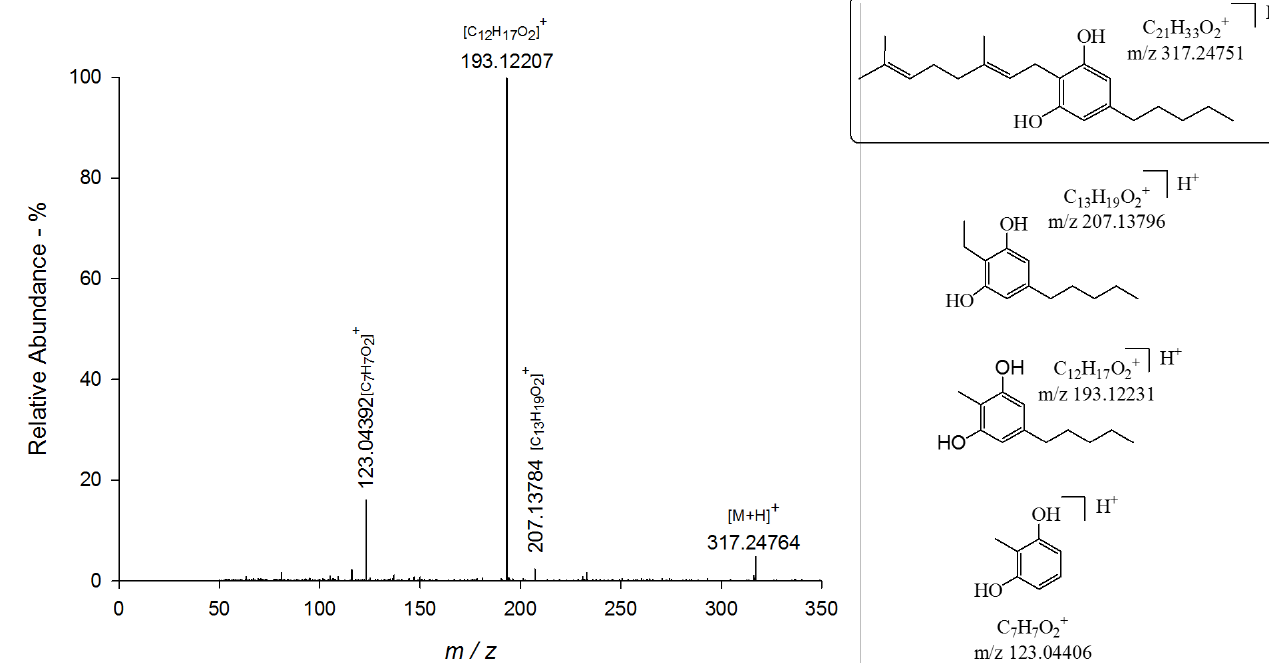
Figure 7. FTICR IRMPD MS spectrum, of the protonated cannabinoid CBG at m / z 317.24764 (peak three in the chromato- grams of Figure 1); the [M+H] + precursor ion was photon-irradiated for 290 ms at 100% laser power to obtain the product ions at m / z 207.13784, 193.12207 and 123.04392, which structures are reported on the right side of the mass tandem spec- trum.